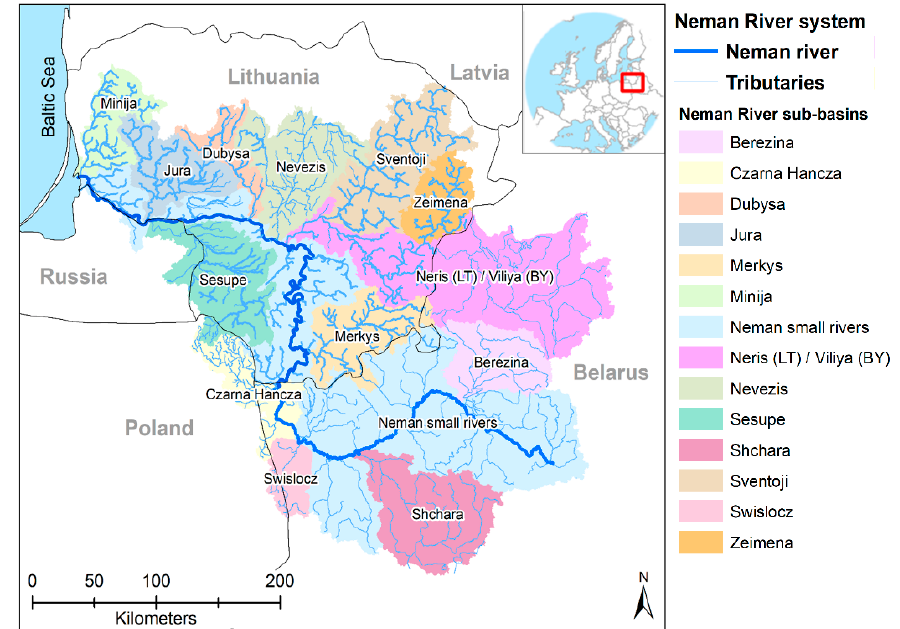
Figure 1. Map of the Neman River basin, its sub-basins, and tributaries in the territories of Belarus, Lithuania, Poland, and Russia (Kaliningrad region).